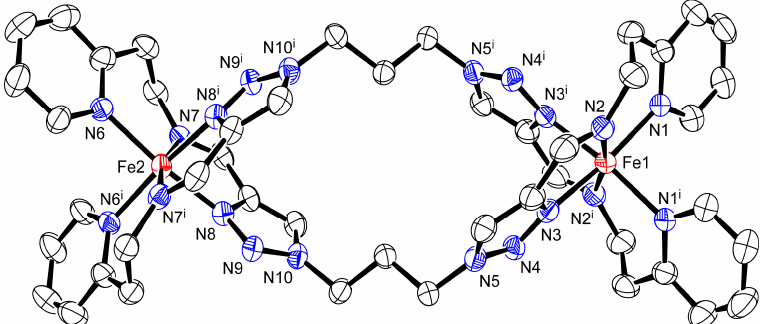
Figure 3. ORTEP drawing of the dinuclear double helicate complex-cation [Fe II2 (L2 C3 ) 2 ] 4+ of 1·AsF 6 at 120 K with the atom numbering scheme except for carbon atoms, where the thermal ellipsoids are drawn with a 50% probability level. H atoms have been omitted for clarity. Symmetry operation: (i) –x, y, 3/2 − z.